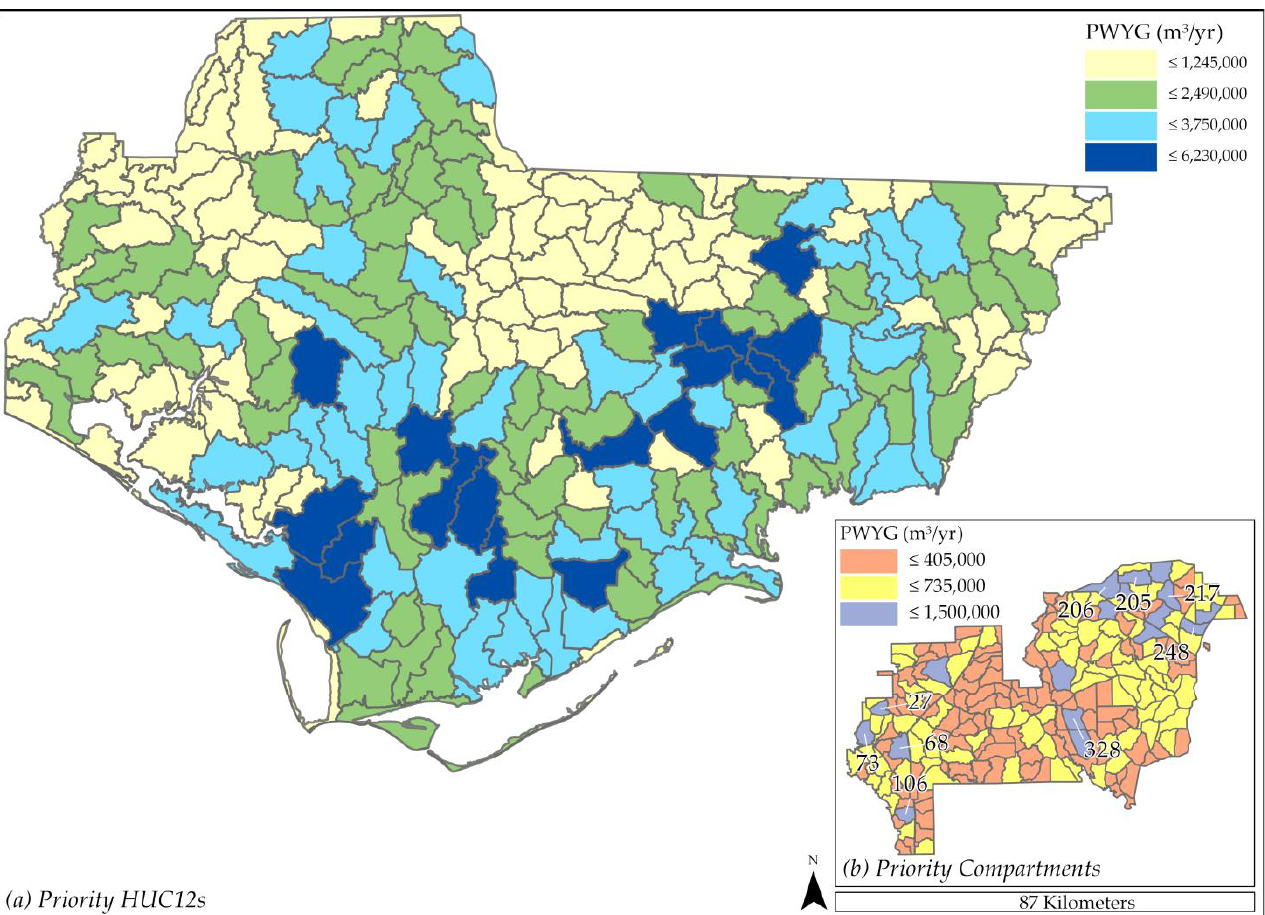
Figure 7. HUC12 potential water yield gain (PWYG) in m 3 /yr from current (2018) conditions to timber thinning scenario 7 basal area is shown in ( a ) with highest PWYG HUCs labeled. Forest compartment PWYG from current (2018) conditions to 7 basal area thinning scenario is shown in ( b ). Ten subwatersheds appeared near the top for PWYG in all three scenarios. These subwatersheds are shown in Figure 7a. Cat Creek, a subwatershed that is wholly contained within Tate’s Hell State Forest, had the highest PWYG in every timber thinning scenario